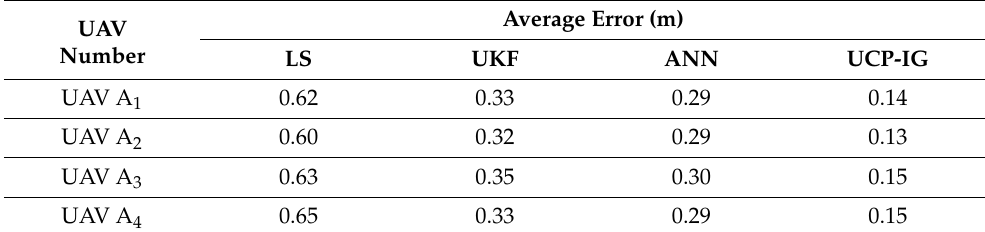
Table 5. Average positioning errors (experimental random